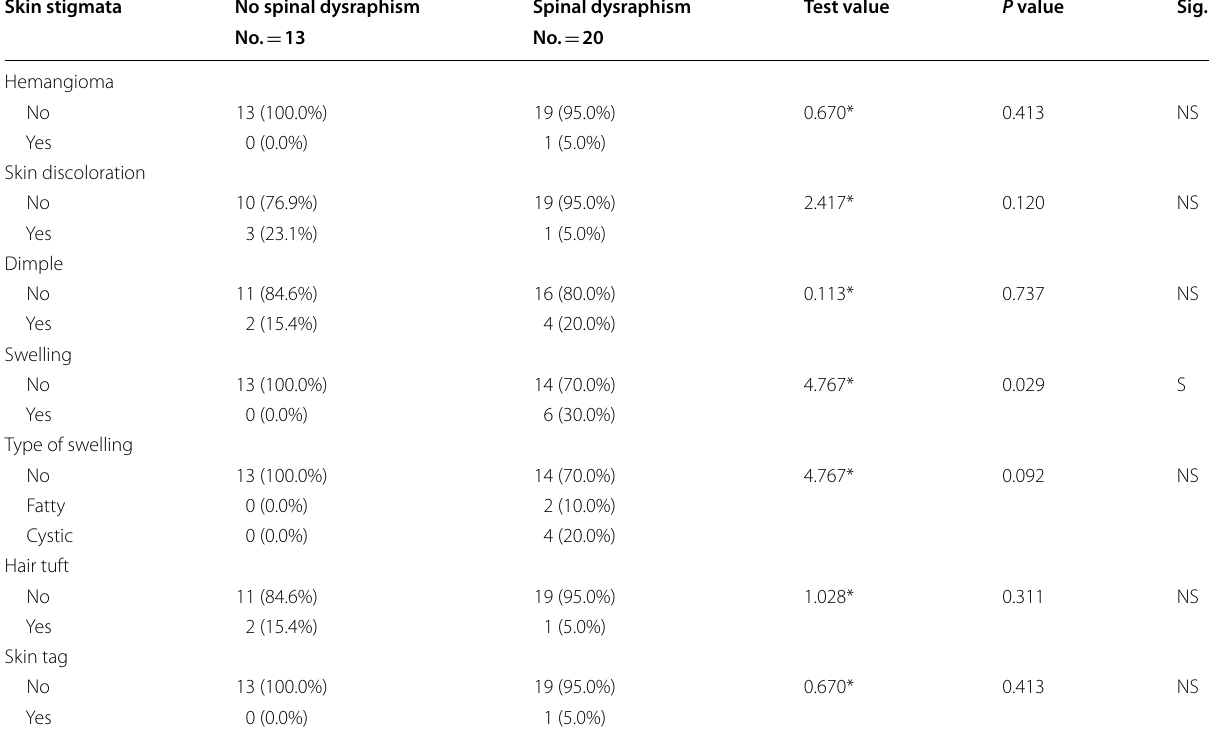
Table 4 Association between each type of back cutaneous stigmata and spinal dysraphism and its